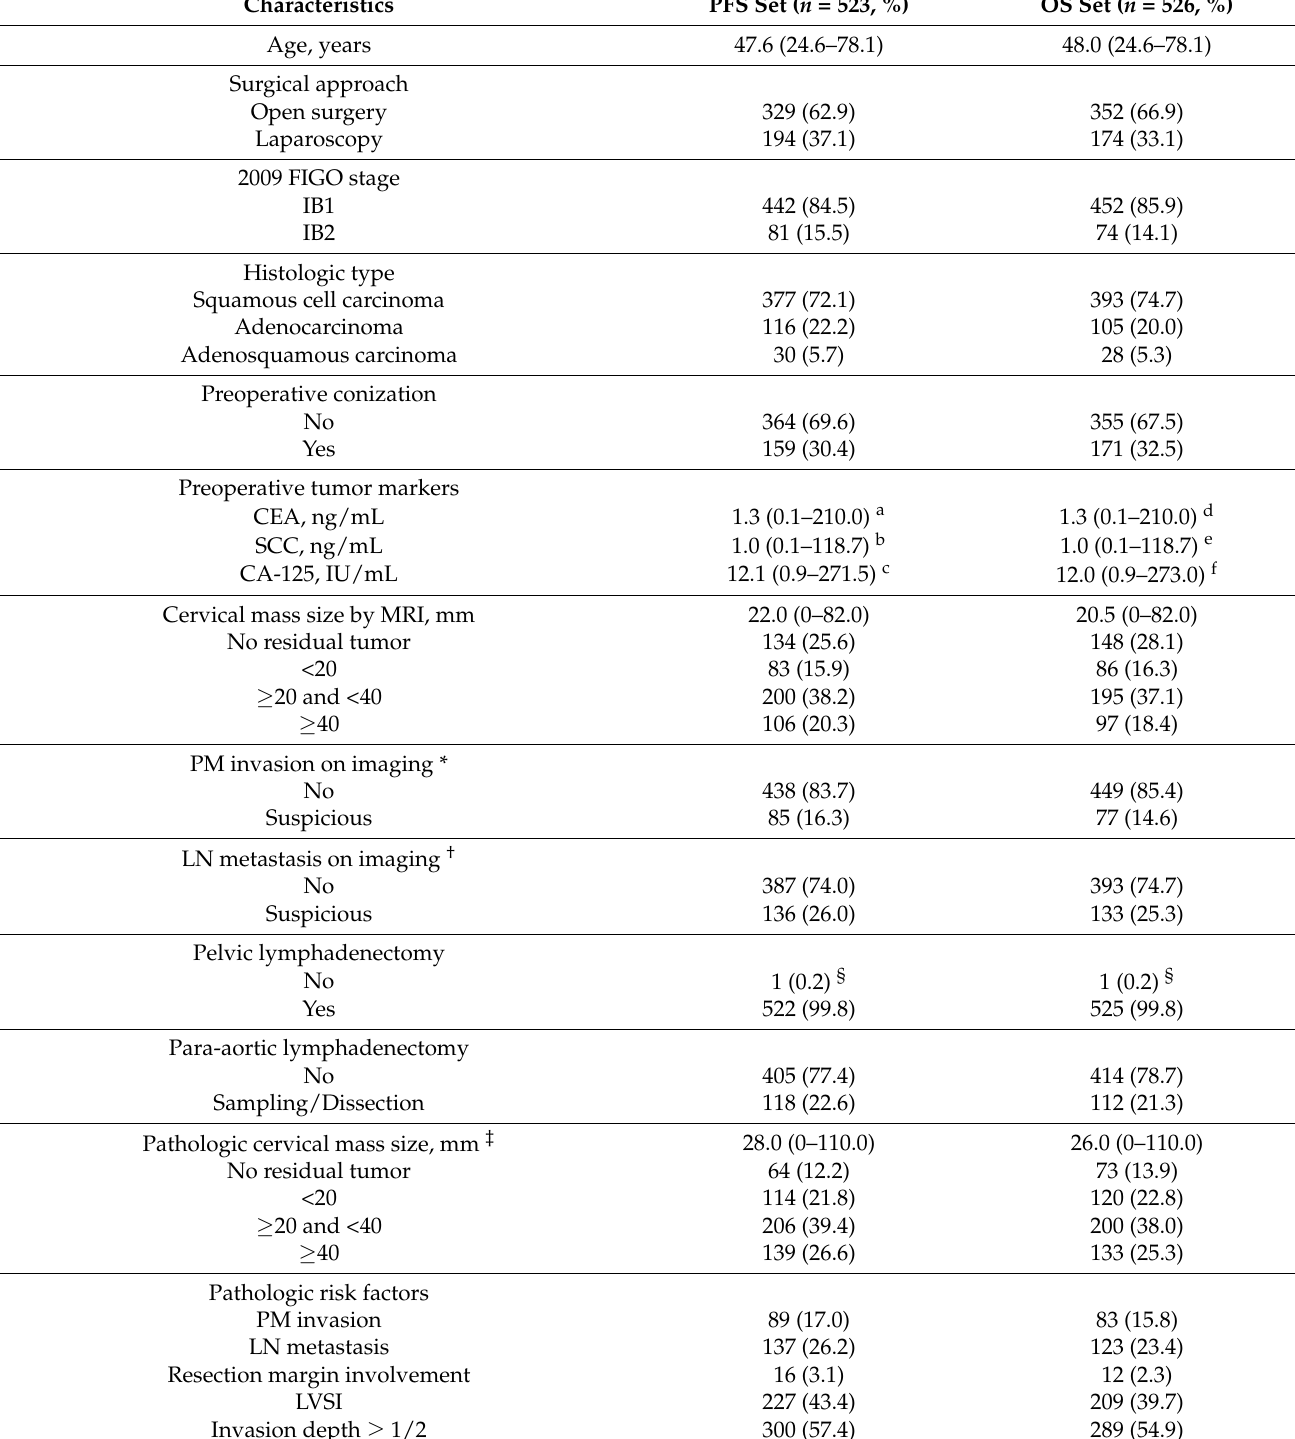
Table 1. Clinicopathologic characteristics of PFS and OS